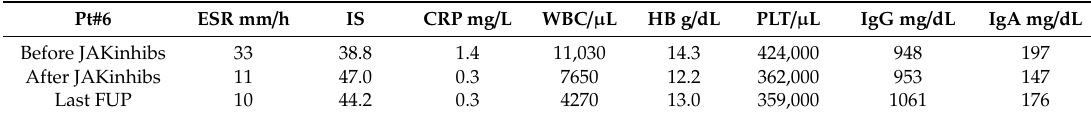
Table A6. Patient #6 laboratory findings.